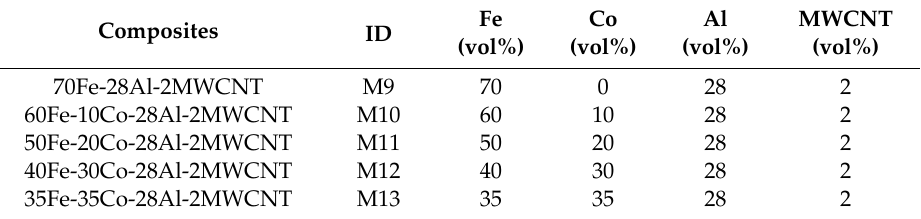
Table 2. Element volume ratio in Fe-Co-Al-MWCNT hybrid nanocomposite materials.